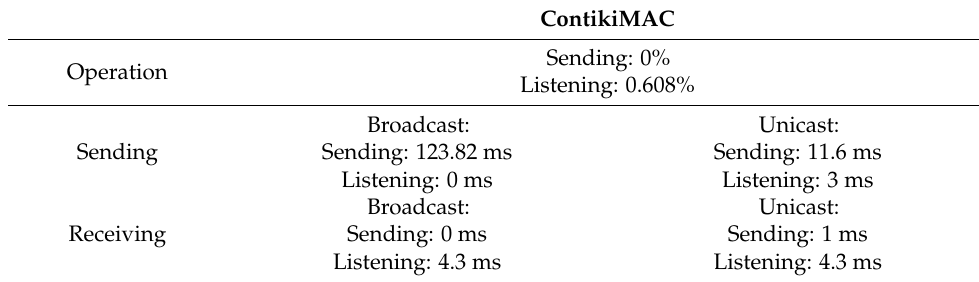
Table A1. The theoretical time needed to operate the ContikiMAC and to send/receive